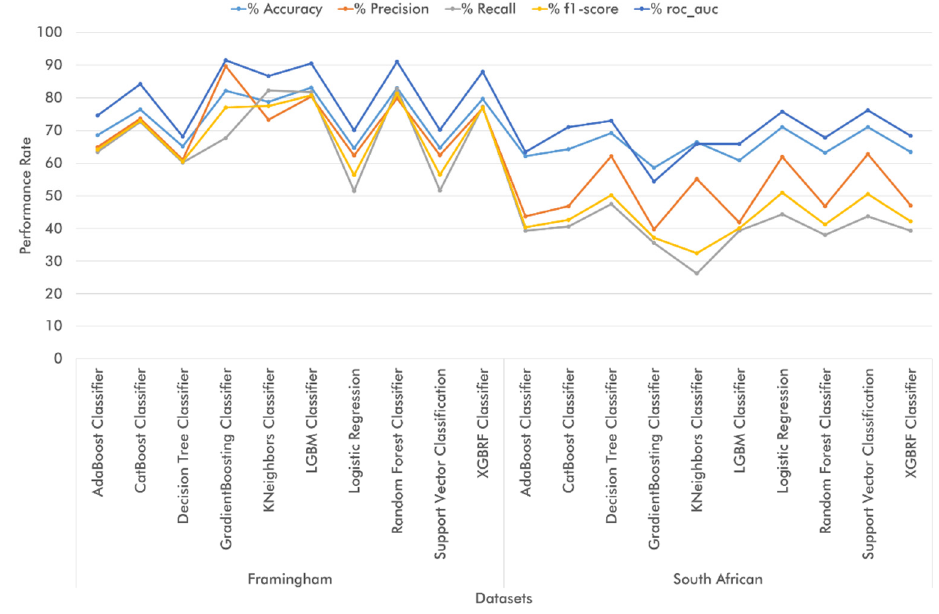
Figure 7. K-fold cross-validation performance of ten ML classifiers on top-four attributes from the Framingham and South African Hearth datasets.